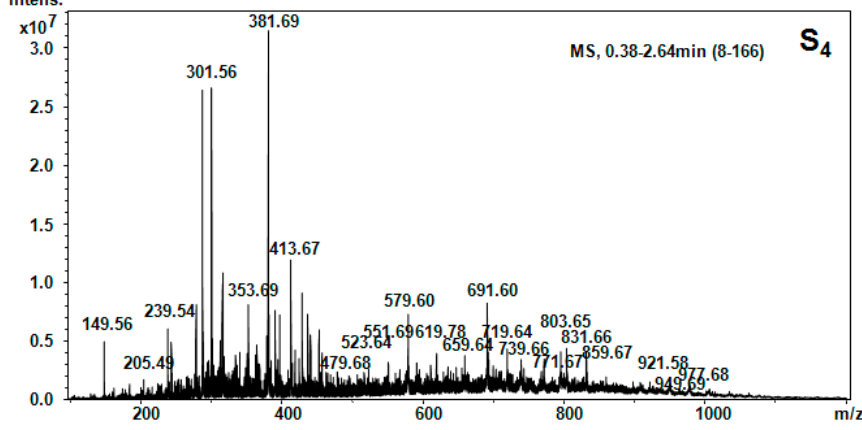
Figure 6. Positive ion mode nano-ESI-Chip-MS for S 4 hellebore fraction.